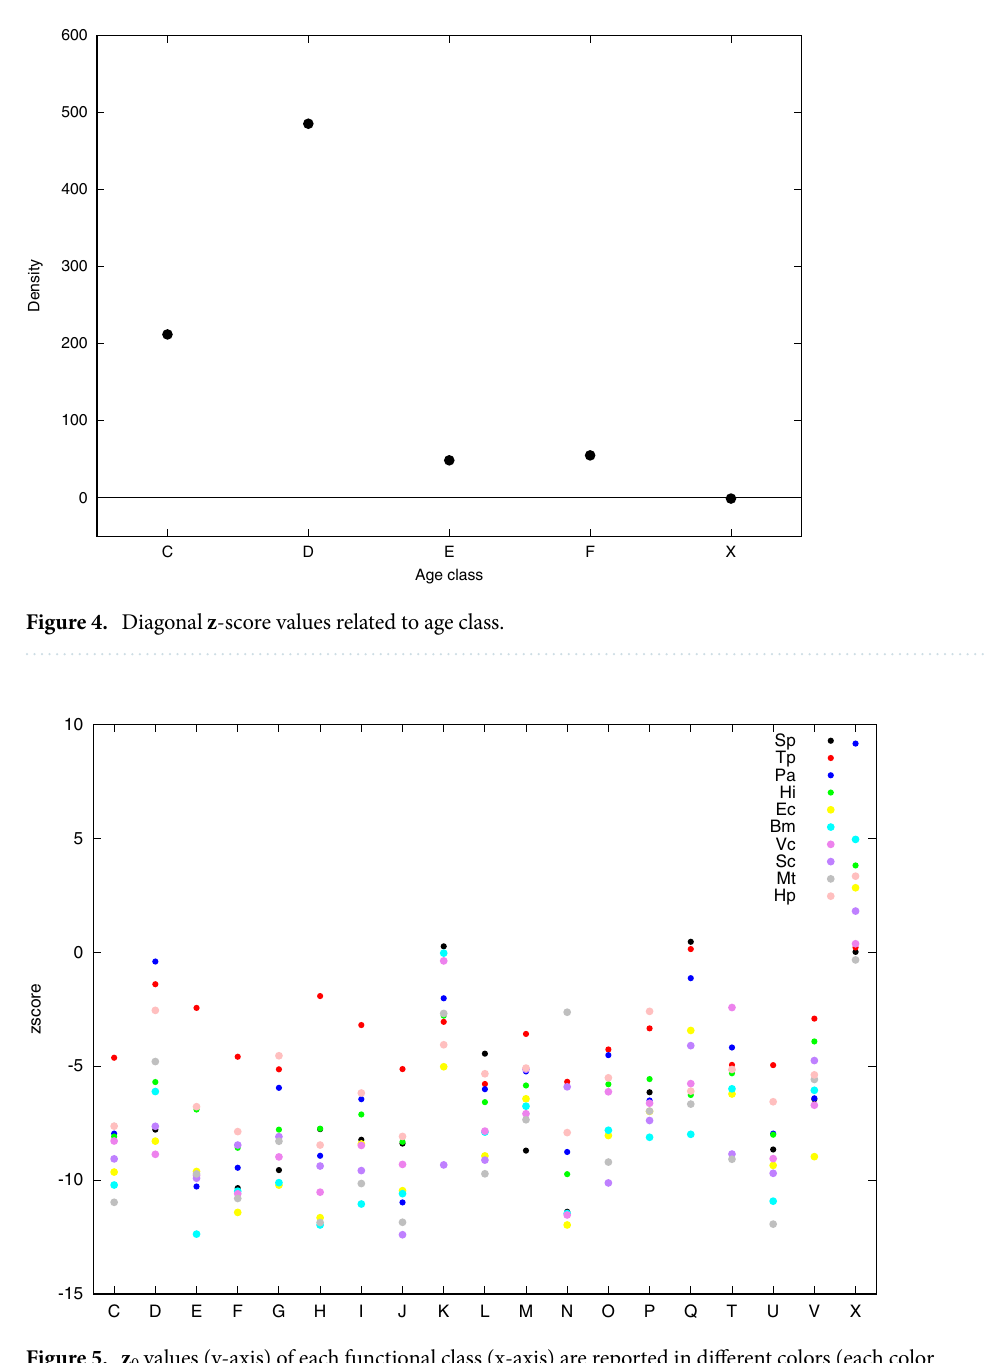
Figure 5. z 0 values (y-axis) of each functional class (x-axis) are reported in different colors (each color representing a different organism as indicated in the top right legend of the